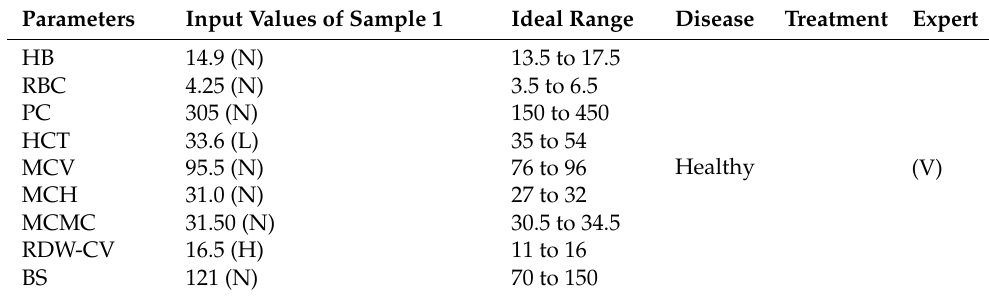
Table 4. Sample 2 and its